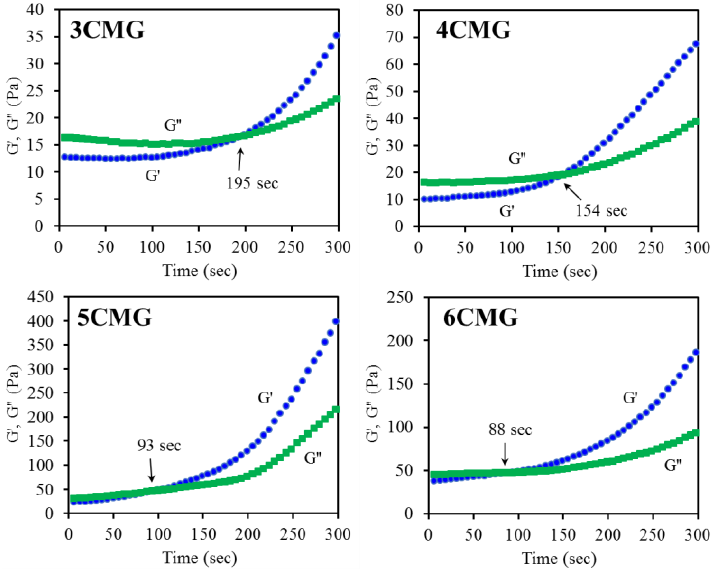
8 of 17 Table 1. Gelation temperature and gelation time of CMG hybrid hydrogels. Sample Code